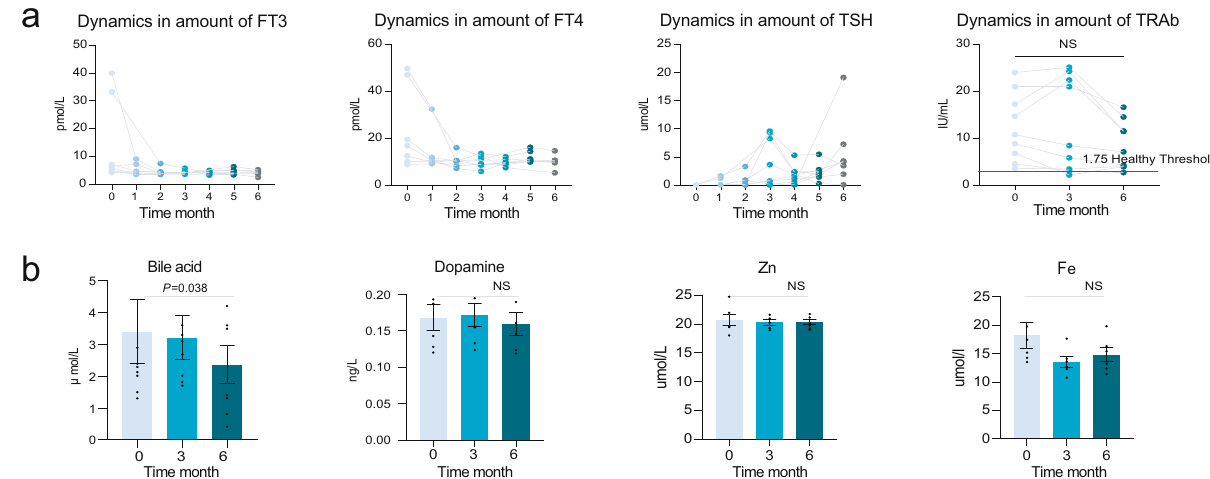
Fig. 4 The black bean adjuvant methimazole intake improved the thyroid function of GD patients. a Dynamic in the concentration of thyroid indexes including FT3, FT4, TSH, and TRAb during the whole experiment, these indexes were determined monthly. b Dynamic in the concentration of bloody bile acid, Dopamine, Zn, and Fe, these indexes were determined at baseline, month 3 and month 6.